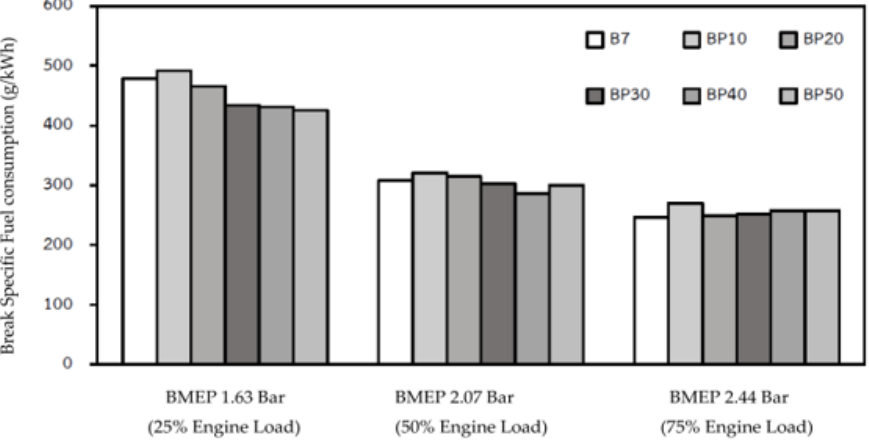
Figure 4. Effects of fuel blends in brake specific fuel consumption under various engine loads.